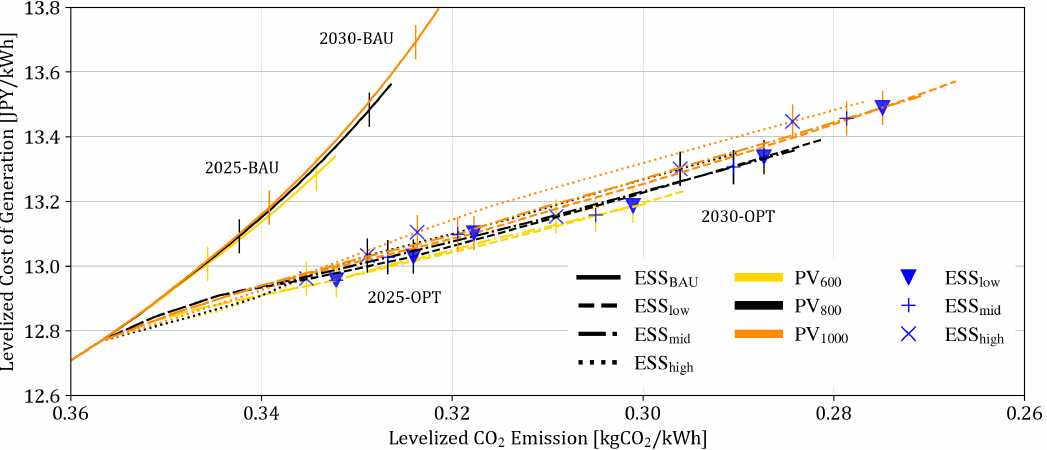
Figure 17. Ratio of the annual Levelized cost of generation and levelized CO 2 emissions for the various scenario. The CO 2 emissions (abscissa) are formatted in decreasing order to emphasize the trend. The additional blue markers show the values for 2025 and 2030 for the different